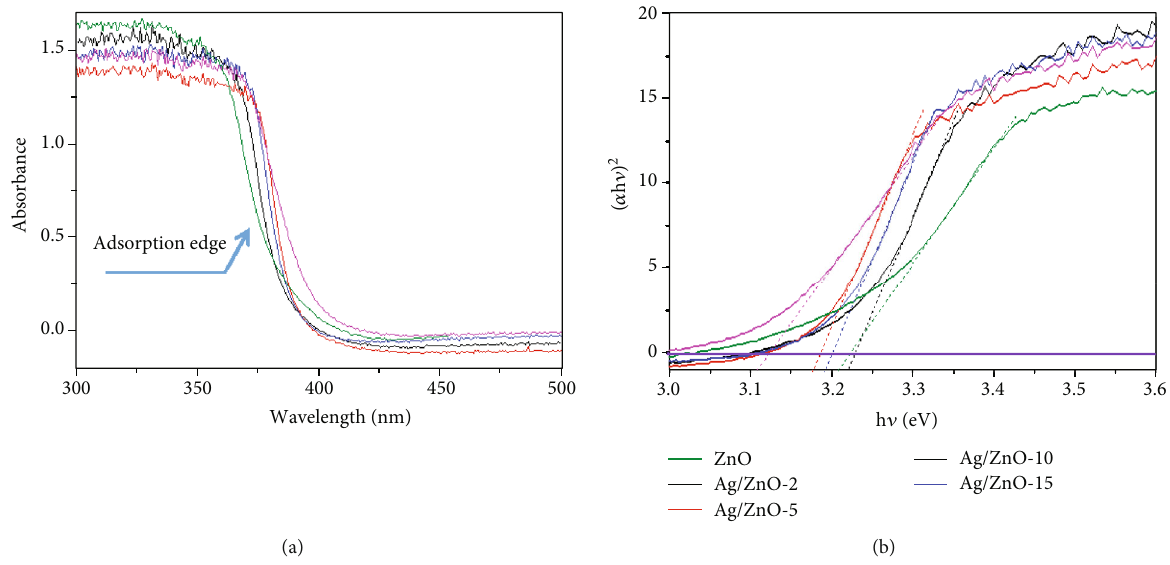
Figure 5: (a) UV-Vis di ff use re fl ectance spectra and (b) Tauc ’ s plot of the as-synthesized samples.